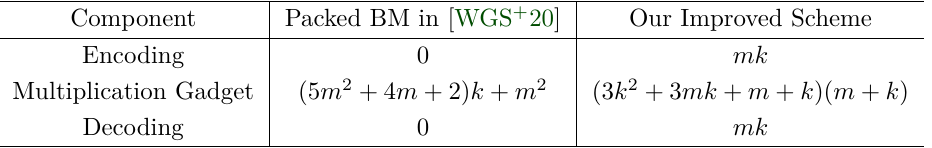
Table 2: Computational complexity of field multiplications for